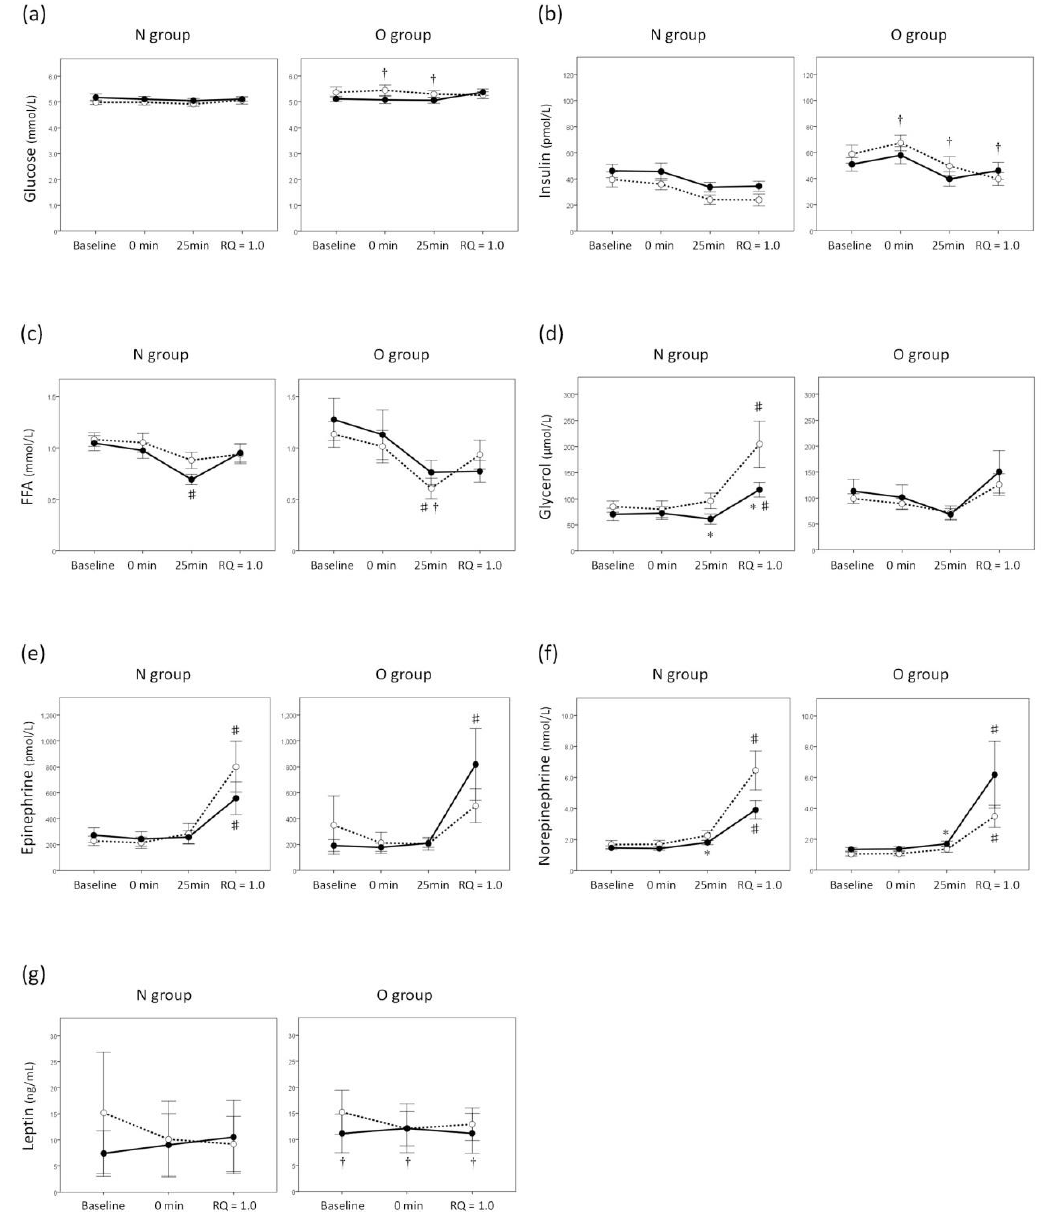
Figure 3. Changes in blood parameters during the graded exercise in both trials. Blood glucose ( a ), insulin ( b ), free fatty acid (FFA) ( c ), glycerol ( d ), epinephrine ( e ), norepinephrine ( f ), and leptin ( g ) levels in the placebo (PL) and the insulin (INS) trials are indicated by white and black circles, respectively. All values are presented as the means ± SEM. # : p < 0.05 vs. baseline. *: p < 0.05 vs. PL. † : p < 0.05 vs. N group.